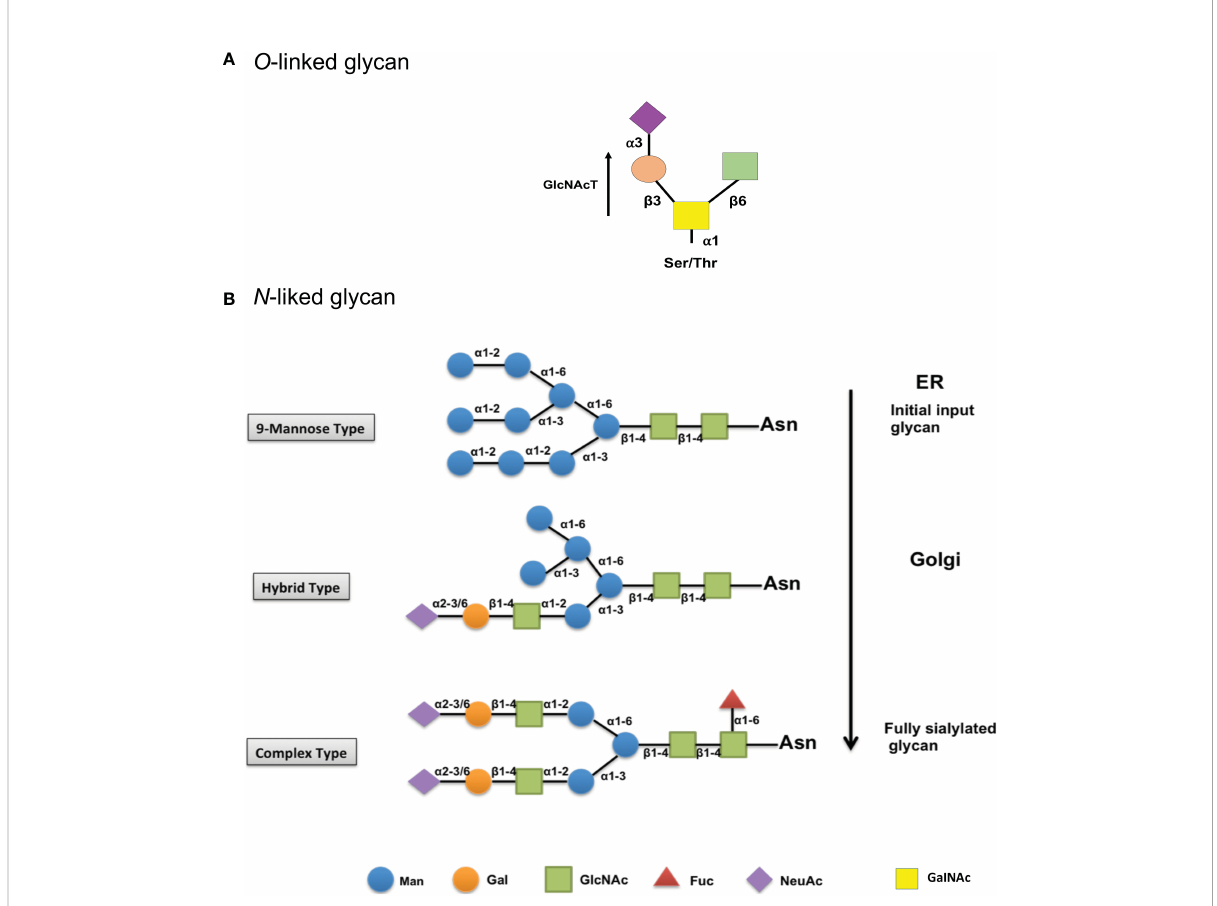
FIGURE 2 Biosynthesis and structure of O - and N -linked glycans. (A) Initial biosynthetic pathway of O -glycans with an O -GalNAc moiety starts in the Golgi apparatus, where a GalNAc residue is attached by different polypeptide polypeptide GalNAc transferases (GlcNAcT). Later, a few glycosyltransferases can convert the resulting glycoprotein into different core structures. (B) The biosynthetic pathway of the early input glycan (9-mannose glycan) begins in the endothelial reticulum (Top). Then, glycoprotein migrates to the Golgi, where the mannose group is removed, and other monosaccharides are added in a hybrid type process (mid). The biosynthetic process is then fi nished as a completely sialylated glycan complex in the Golgi (Bottom). Man, mannose; Gal, galactose; GlcNAc, N -acetylglucosamine; Fuc, fucose; NeuAc, sialic acid; GalNAc, N